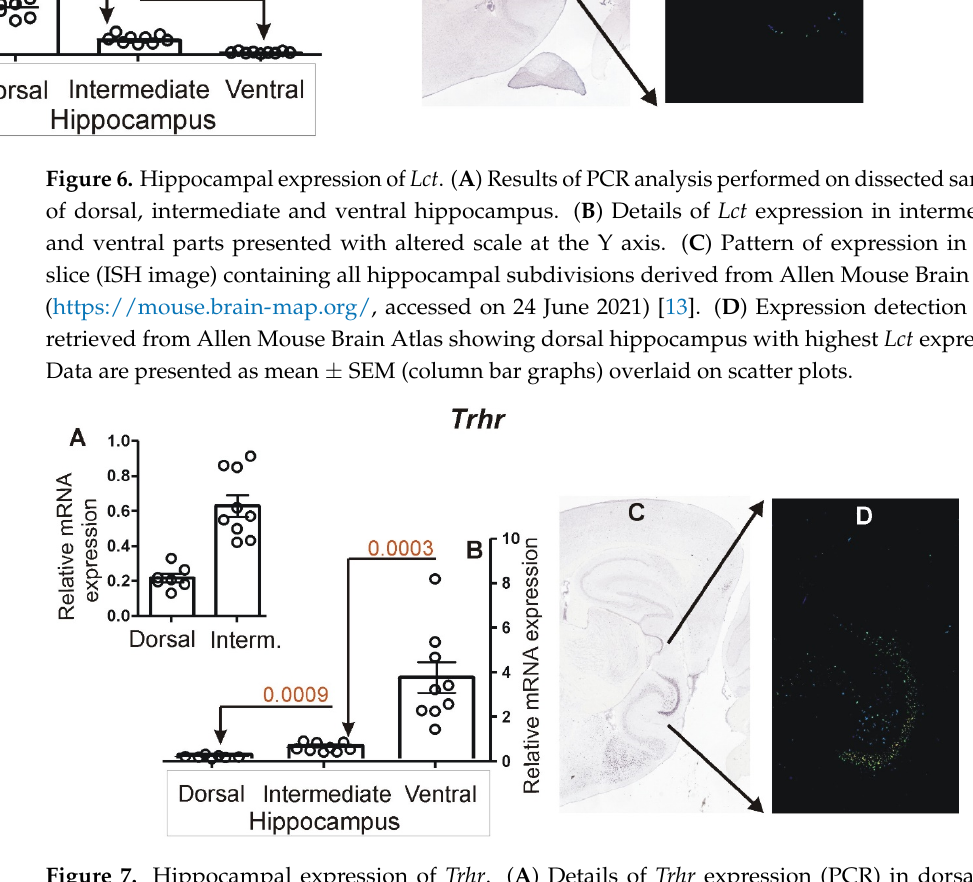
Figure 7. Hippocampal expression of Trhr . ( A ) Details of Trhr expression (PCR) in dorsal and intermediate parts presented with an altered scale at the Y axis. ( B ) Results of PCR analysis performed on dissected samples of dorsal, intermediate and ventral hippocampus. ( C ) Pattern of expression in a brain slice (ISH image) containing all hippocampal subdivisions derived from Allen Mouse Brain Atlas (https://mouse.brain‐map.org/, accessed on 24 June 2021) [13]. ( D ) Expression detection mask retrieved from Allen Mouse Brain Atlas showing mediodorsal hippocampus with highest Trhr expression. Data are presented as mean ± SEM (column bar graphs) overlaid on scatter plots.